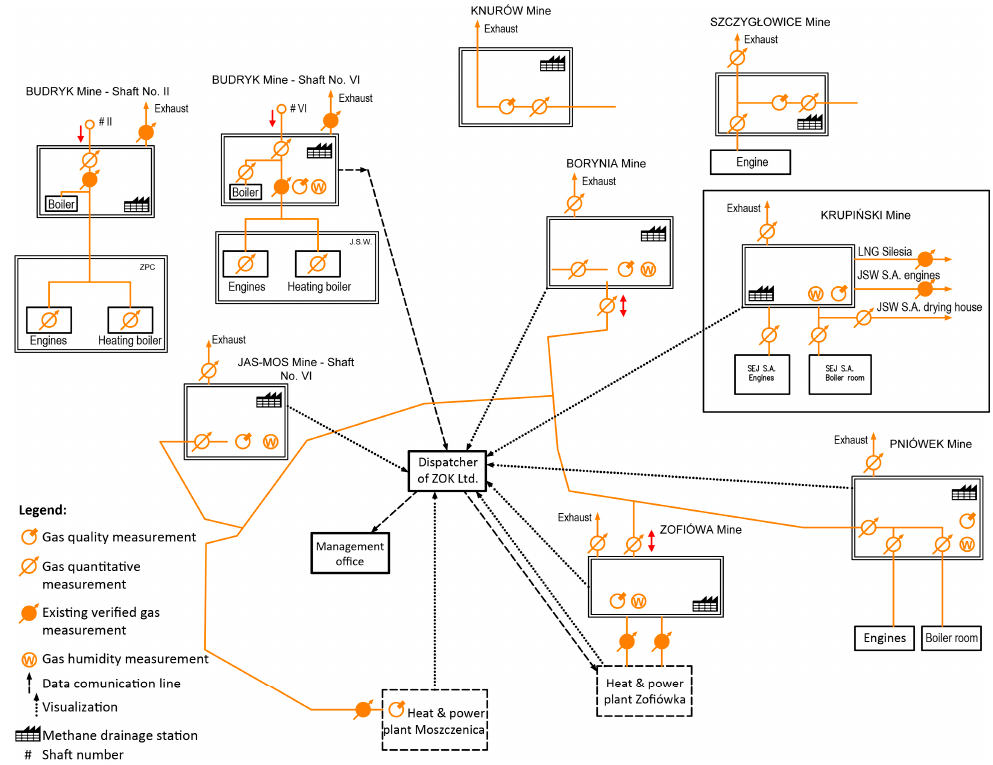
Figure 4. A diagram of distribution and methods of methane utilisation in Jastrz˛ebska Sp ó łka W˛eglowa S.A. (JSW